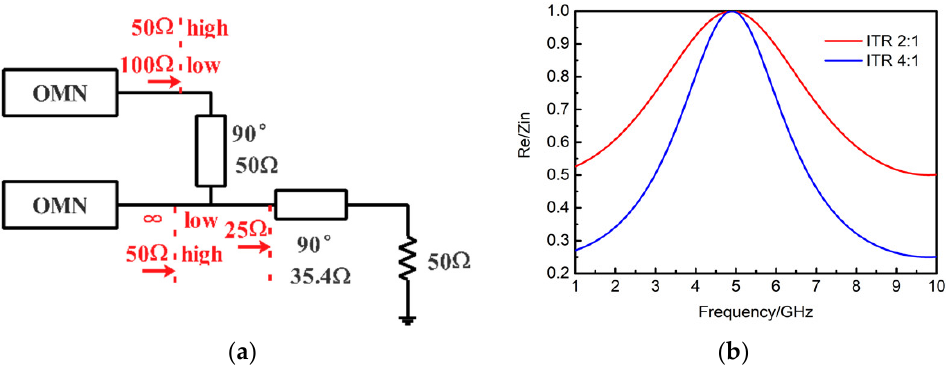
Figure 8. ( a ) Conventional topology ( left ); ( b ) The impact of different impedance transformer ratios (ITRs) on bandwidth ( right ).